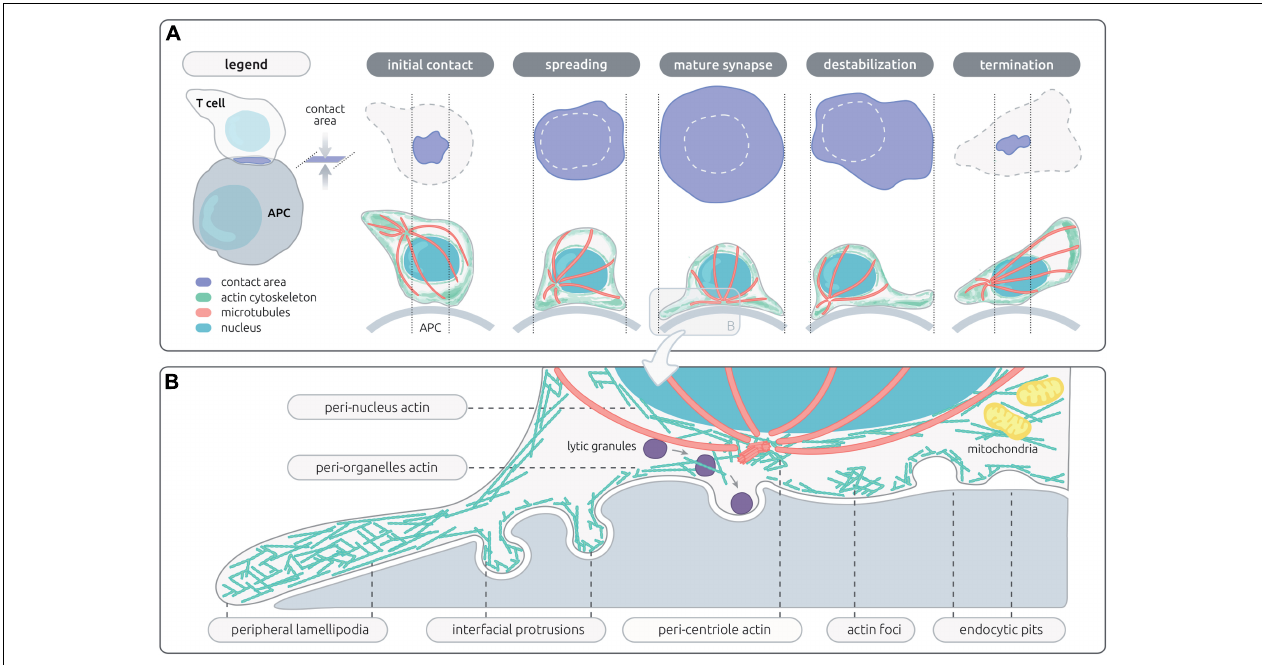
FIGURE 1 | Actin networks sustaining T cell synapse shape and microarchitecture. (A) Schematic representation of the en-face and side views of the contact area between a T cell and an antigen-presenting cell (APC). The successive steps of the IS life cycle are depicted, from initial T cell/APC contact to termination of the IS. The contact area, actin cytoskeleton, microtubules and nucleus are represented with the indicated colors. (B) Schematic representation of the microarchitecture of a mature IS, corresponding to a transversal view of the contact between a CD8 + T cell and a target cell. This representation assembles the different actin networks described so far in the context of lymphocyte activation, including those proximal to the plasma membrane and those associated with inner organelles of the